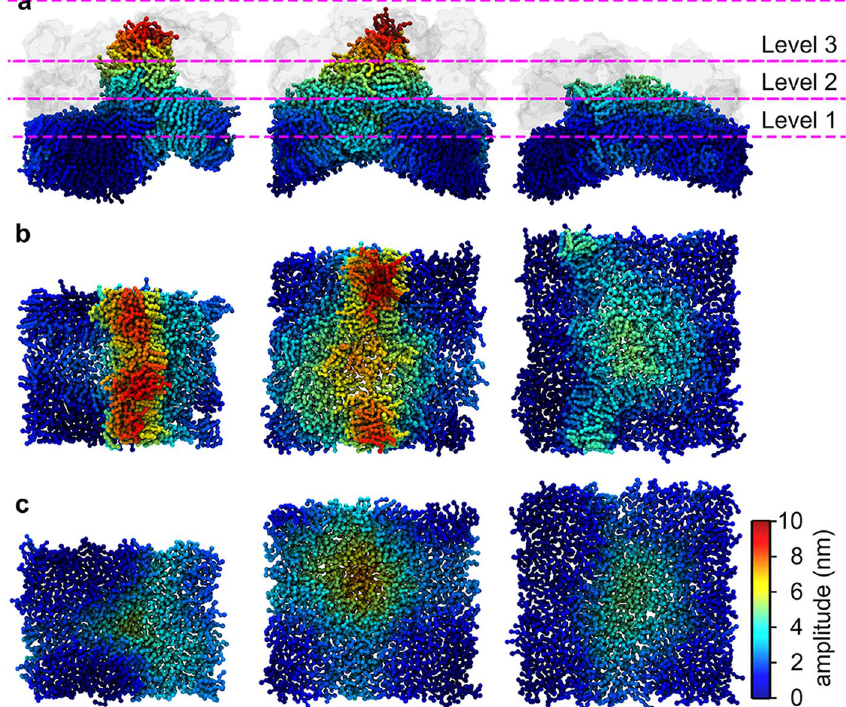
Figure 3. Levels of membrane perturbation. ( a ) Side views of the VI, IN, and HO membranes at 100 µ s are shown from left to right. Clusters of kB1 molecules are shown as transparent surface models. The dashed lines show the levels of the distance amplitude in the outer layers of the membranes. The ( b ) top and ( c ) bottom views of the outer and inner layers of the membranes are shown. The lipid molecules are shown as CPK models. The color of each lipid molecule represents its amplitude (see the color scale bar). In ( b ) and ( c ), the kB1 molecules are not